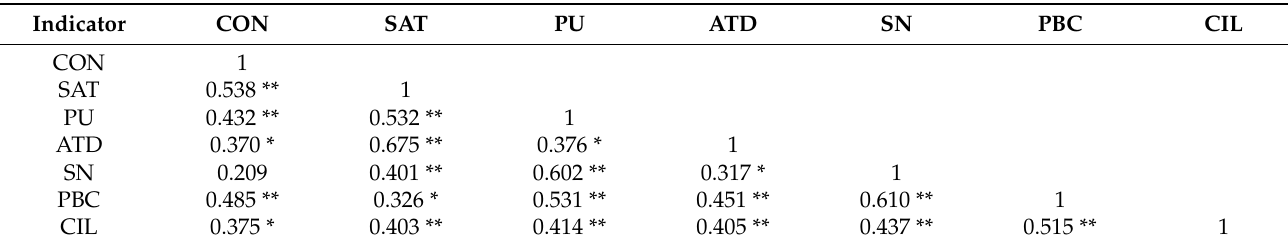
Table 2. Correlation